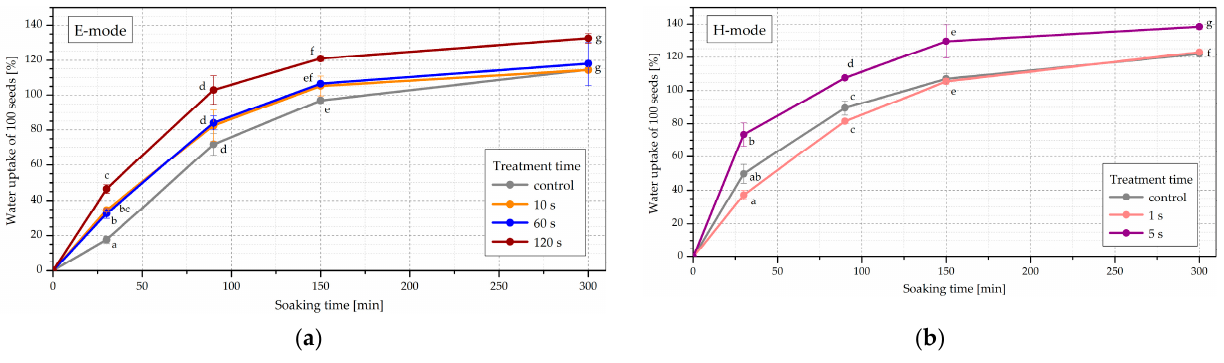
Figure 3. Water uptake of 100 alfalfa seeds after treatment with ( a ) an E-mode plasma or ( b ) an H-mode plasma at selected treatment times and soaked in water. The error bars represent standard error. Different lowercase letters next to data points represent statistically significant differences ( p < 0.05; post hoc Tukey’s range tests) between treatments at each individual soaking time.